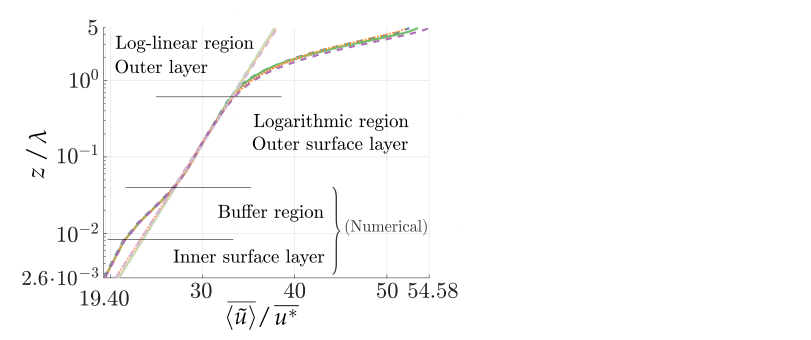
Figure 7. Wind longitudinal velocity profiles, with different colors for Cases 01 to 05 of the flat- bottom application. The log law fitting to the outer surface layer (by Equation (15)) is shown with transparent